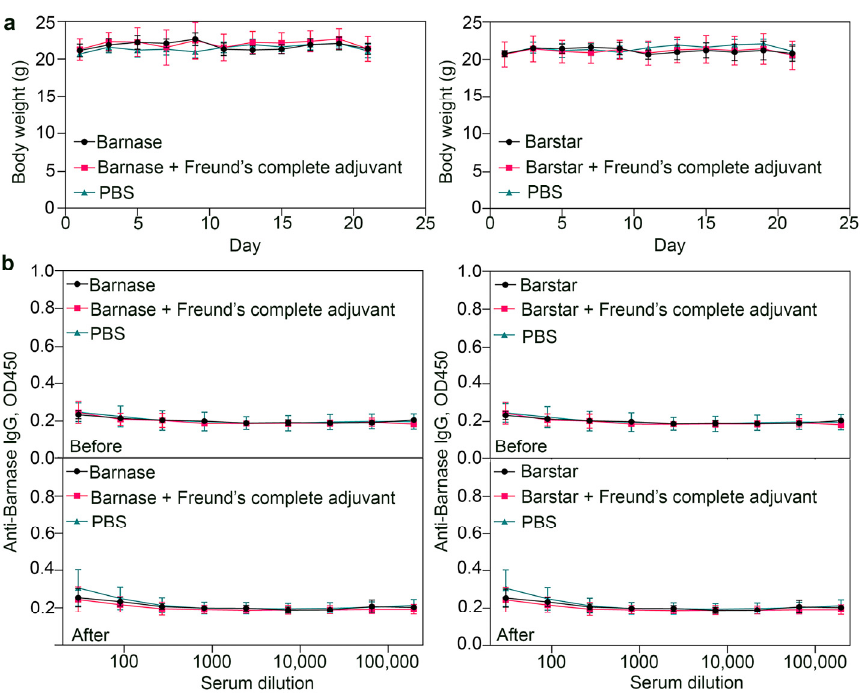
Figure 8. Immunogenicity study of barnase and barstar. ( a ) Body weight dynamics after the sequential injections of barnase or barstar for the experimental and control animal groups (n = 3–5 mice). ( b ) Study of a protein-specific immune response for the proteins barnase and barstar. BALB/c immunocompetent mice were used as experimental animals. The graphs show the absorption of the phosphatase substrate, corresponding to the quantity of antibodies specific to barnase or barstar, depending on the blood serum dilution in blood samples before and after the sequential administration of the corresponding proteins.